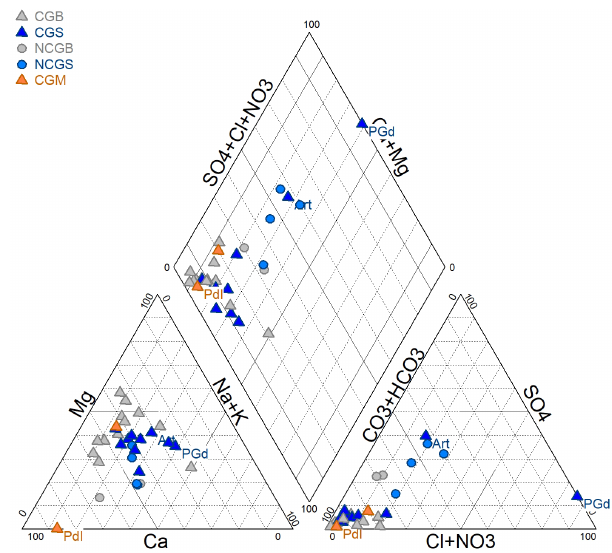
Figure 4. Piper diagram representing the relative proportion of cations and anions for each sample. CGB = carbogaseous water from the Bru area, CGS = carbogaseous water from the Spa area, NCGB = non-carbogaseous water from the Bru area, NCGS = non- carbogaseous water from the Spa area, and CGM = carbogaseous water from the Malmedy